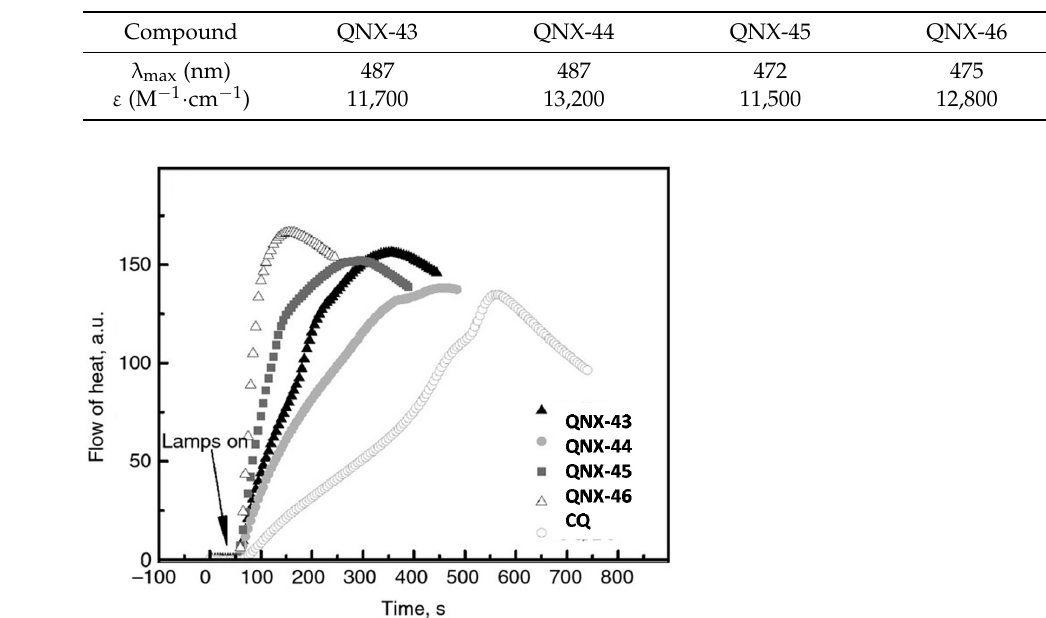
Figure 38. UV-visible absorption spectra of QNX-43-QNX-46 in 1-methyl-2-pyrrolidone. Reprinted from Ref. [247], Copyright 2014, Wiley. Table 14. Optical characteristics of QNX-43-QNX-46 in 1-methylpyrrolidone.